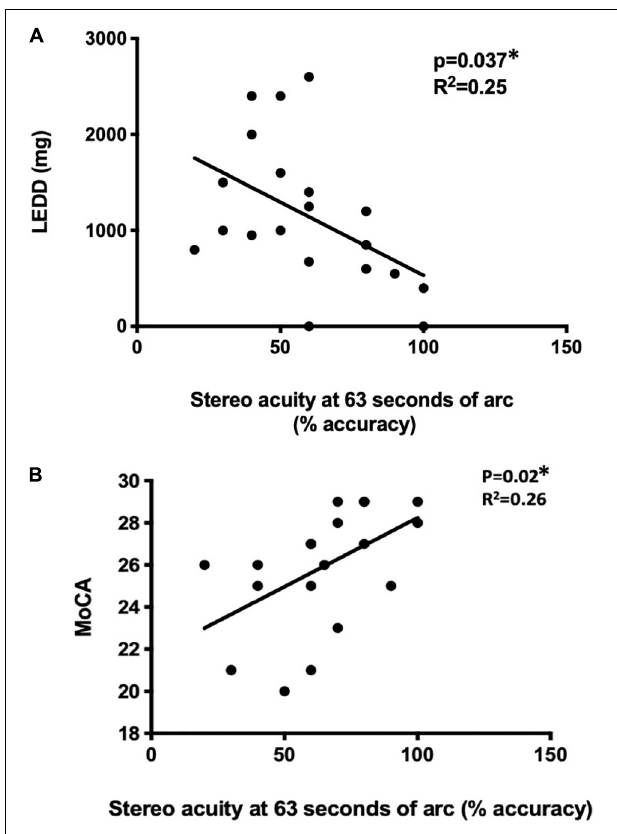
FIGURE 4 | The correlation of disease status with stereo acuity. Disease severity was reflected by LEDD (A) and cognitive function was assessed MoCA (B) . ∗ p < 0.05, using univariate regression models. LEDD, levodopa equivalent daily dose (mg), MoCA, Montreal Cognitive